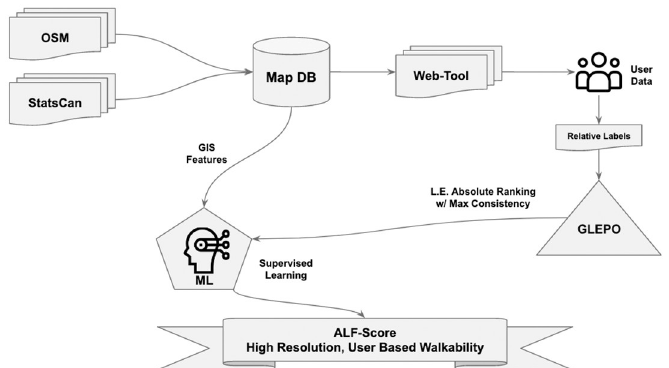
Fig 2. ALF–Score core pipeline. ALF–Score utilizes various GIS features such as road network structure, POI as well as features derived from road networks such as various centrality measures and road embedding. GLEPO’s linear extension of user opinions that produces a global view of relative user opinions is then aligned with the GIS features as an input of our supervised machine learning processes. Walkability estimates that are produced through trained models will have a high spatial resolution, are representative of user opinion and provide a better insight of different regions and neighbourhoods. (Figure drawn by the